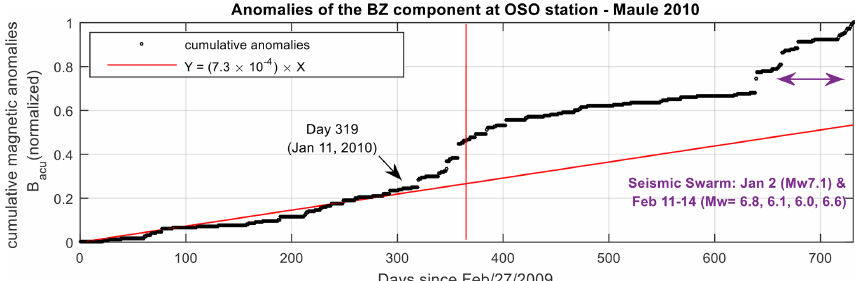
Figure 7. Accumulated magnetic anomalies of B z and a linear interpolation in the period of 2 years starting on 27 February 2009. The data were taken at the OSO station. Close to the main earthquake, the linear trend breaks and the number of anomalies increases. Other important seismic events hit near the stations during the last period. Nevertheless, it is not clear that the anomaly increases are due to these specific events.